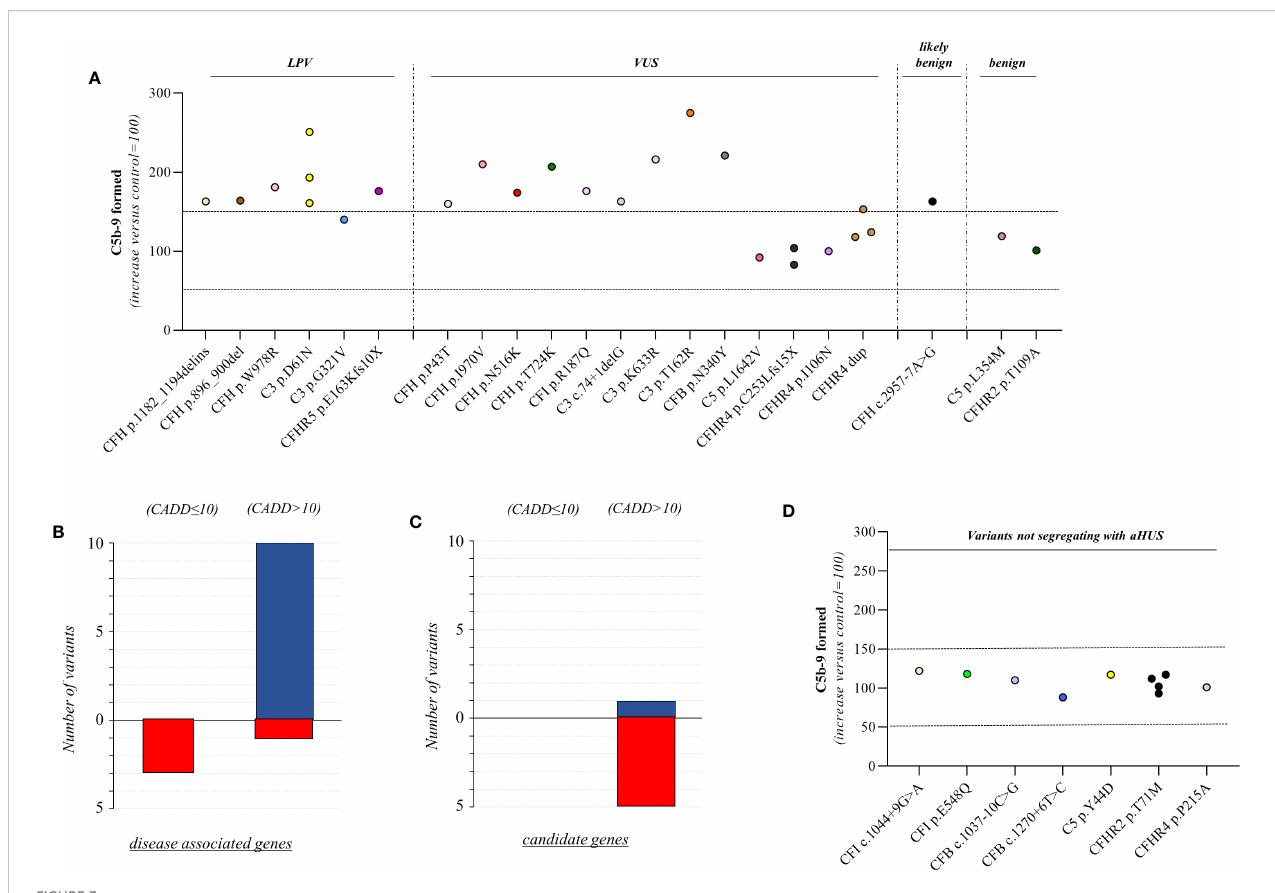
FIGURE 3 C5b-9 formation on HMEC-1 exposed to serum from unaffected relative carriers of rare complement gene variants. (A) Endothelial surface area covered by C5b-9 staining after 2h incubation of ADP-activated HMEC-1 with serum (diluted 1:2 in test medium) from carriers of variants likely pathogenic (LPV, n=8), of uncertain signi fi cance (VUS, n=16), likely benign (n=1), or benign (n=2). Results are shown as fold increase of stained surface area after incubation with serum from unaffected carriers versus control pool of sera run in parallel. Points represent fold increase values for single subjects. Dotted lines are upper and lower limits of normal range. (B) Breakdown of CADD computational predictions using a default score value cutoff >10 in disease- associated genes. (CADD ≤ 10: benign prediction; CADD > 10: pathogenic prediction) (C) Breakdown of CADD computational predictions using a default score value cutoff >10 in candidate genes. Red columns indicate variants with incorrect prediction; Blue columns indicate variants with correct predictions. (D) Endothelial surface area covered by C5b-9 staining after 2h incubation of ADP-activated HMEC-1 with serum (diluted 1:2 in test medium) from carriers of rare variants that do not segregate with aHUS (n=10). Results are shown as fold increase of stained surface area after incubation with serum from carriers of rare variants not segregating with aHUS versus control pool of sera run in parallel. Points represent fold increase values of single subjects. Dotted lines are upper and lower limits of normal